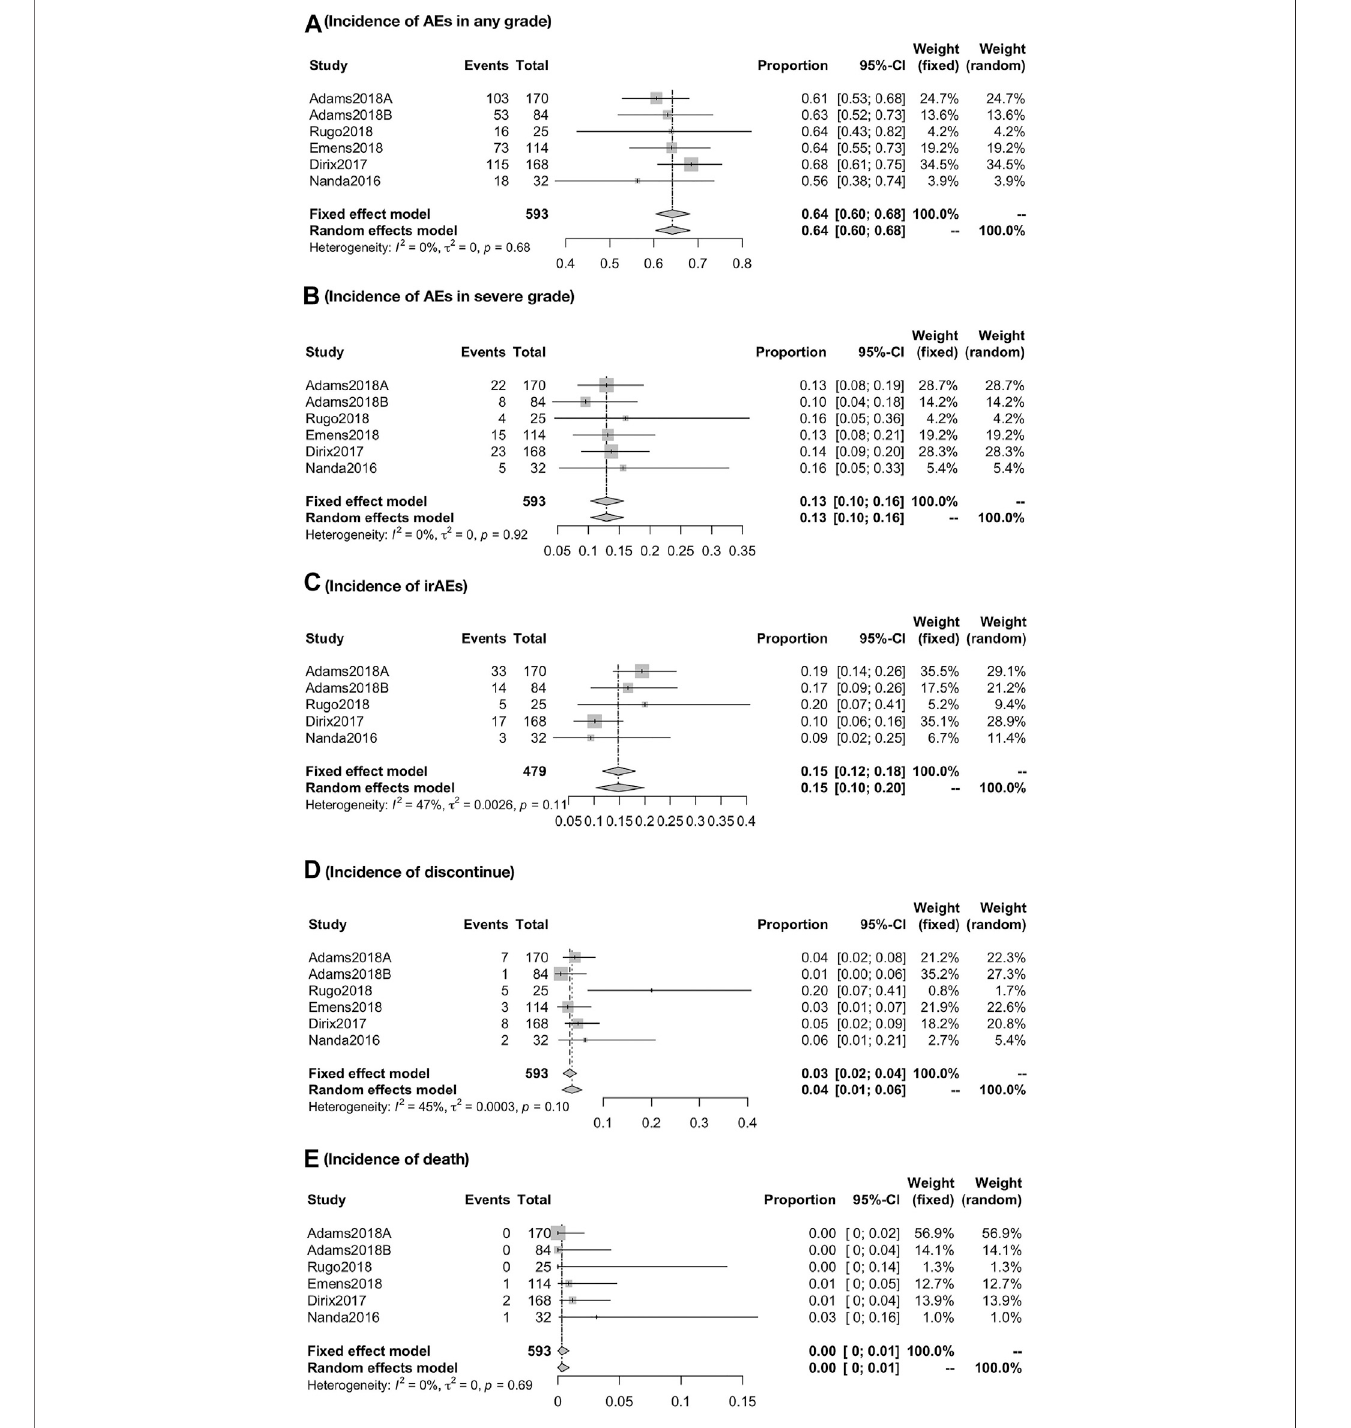
FIGURE5| Global incidence ofAEsinany grade (A) ,inseveregrade (B) ,irAEs (C) ,discontinue (D) ,and death (E) .Theoverallincidence ofAEswas64.18%(95% CI, 60.43 – 68.17; I 2 , 0.00) in any grade and 12.94% (95% CI, 10.36 – 15.76; I 2 , 00.00) in severe grade. The incidence of irAEs was 14.75% (95% CI, 11.72 – 18.06; I 2 , 47.0). Besides, the incidence of discontinue and death due to treatment-related AEs was about 3.06% (95% CI, 1.68 – 4.44; I 2 , 45.50) and 0.31% (95% CI, 0.000.92; I 2 , 0.00), respectively.